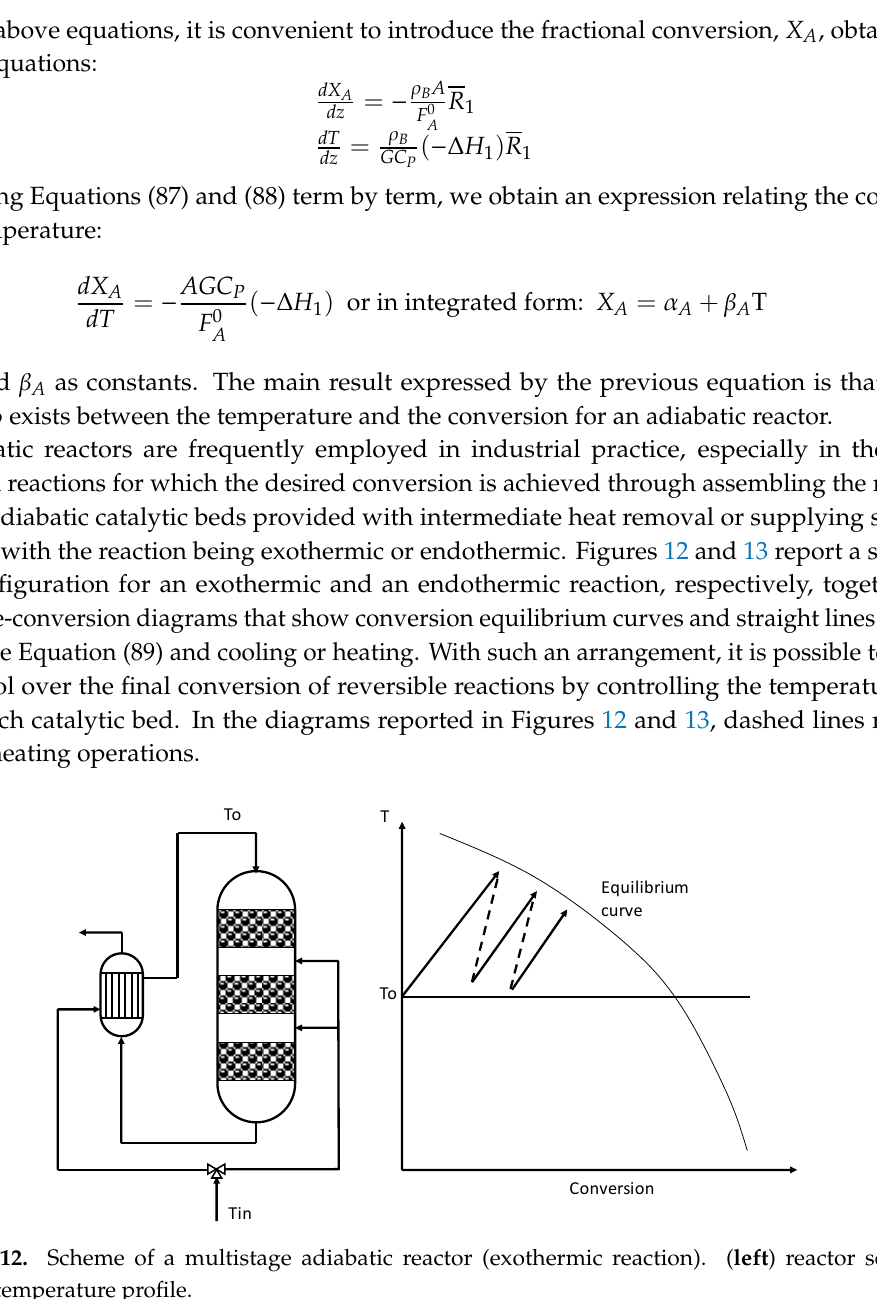
Figure 13. Scheme of a multistage adiabatic reactor (endothermic reaction). ( left ) reactor setup; ( right ) temperature profile. 4. Non-Isothermic and Non-Adiabatic Conditions 4.1. Conversion of o-Xylene to Phthalic Anhydride Let us consider, first of all, a reaction that is performed in a packed-bed tubular reactor, operated in an modality non-isothermal and non-adiabatic that consists in the synthesis of phthalic anhydride (PA) obtained by oxidation of o-xylene (OX) with oxygen (O). A simplified scheme for this oxidation reaction can be expressed as follows: